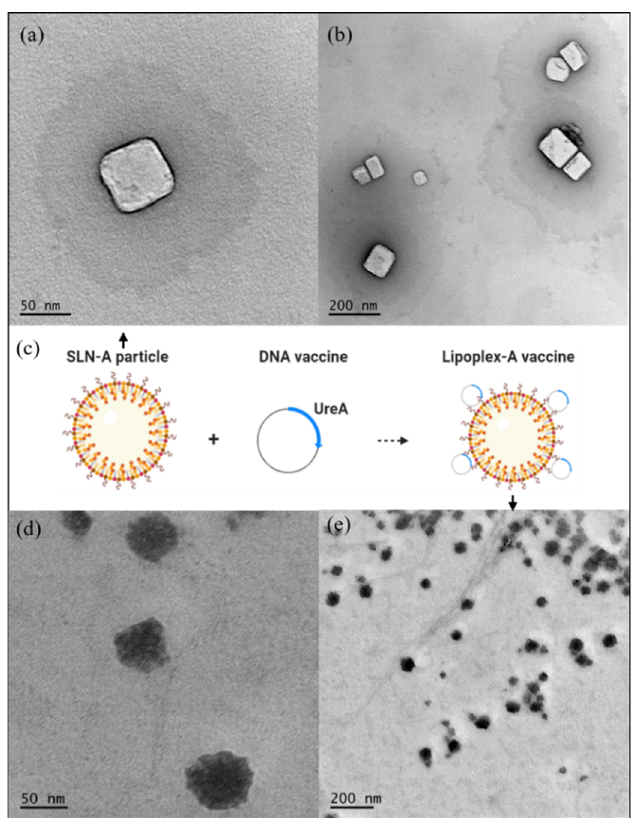
Figure 1. TEM micrographs under 100k accelerating voltage of adjuvanted solid lipid nanoparticle (SLN-A) nanoparticles at ( a ) 50 k magnification and ( b ) 20 k magnification; ( c ) a schematic representation of SLN-A particles binding DNA to form lipoplex-A; ( d ) lipoplex-A imaged at 50 k magnification and ( e ) 20 k magnification. SLN-A nanoparticles were found to be heterogenous in size and cuboid in shape with an average diameter of 75.63 ± 31.99 nm, while lipoplex-A complexes were heterogenous in size with undefined edges and had an average diameter of 74.67 ± 39.93 nm.